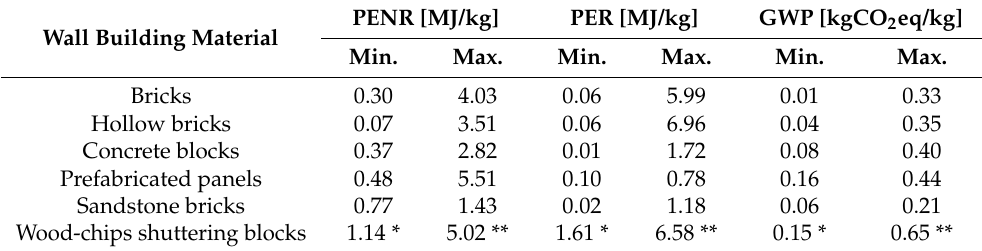
Table 6. Minimum and maximum values of PENR, PER, and GWP of the different products. Stages A1–A3 were considered for all the products analyzed. In addition, if data were available, stage A5 was considered for the shuttering